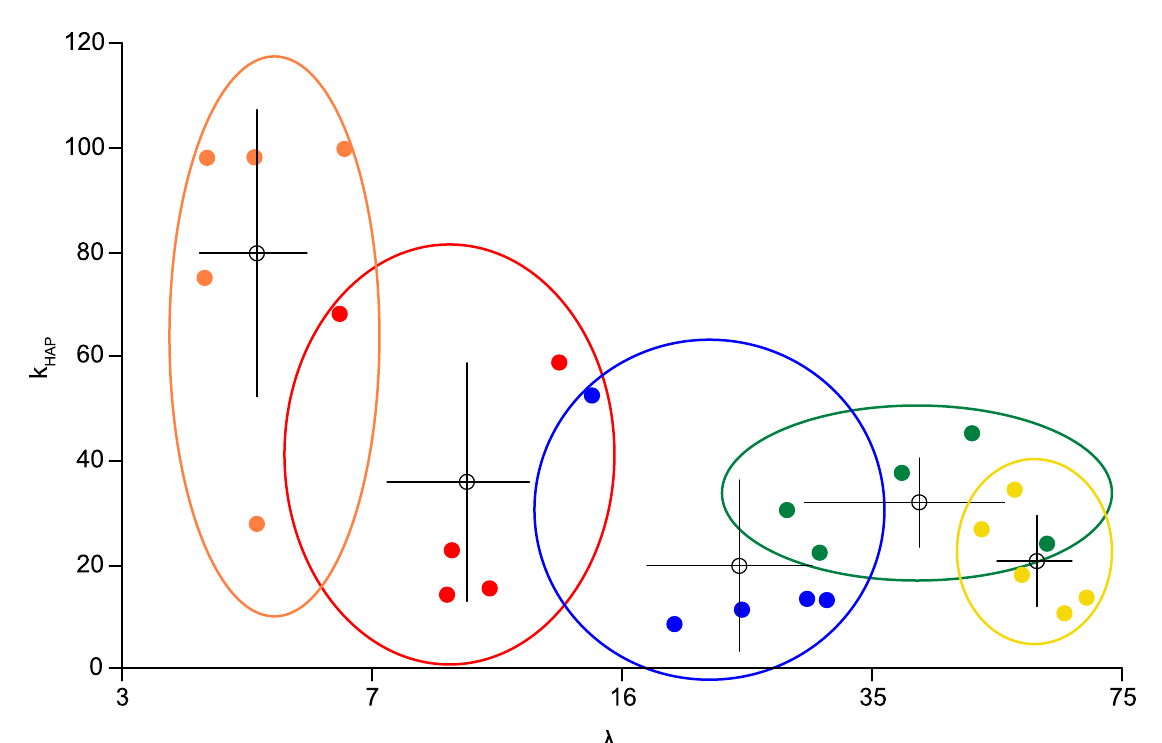
Fig 3. HAP parameter range across cell types and single neuron fits. Each cloud shows five sample fits (each dot a fit) colour coded according to the previously classified VMN cell types (Fig 2). Plotting fits using the HAP fit parameters ( k HAP and λ HAP ), defining the HAP magnitude and half-life, shows a good correlation with cell type. The x-axis is plotted on a natural log scale. The coloured dots show individual cell fits. The white dots and crosses show the mean and standard deviations. The cloud ovals show the range. Longer half-life values tend to correlate with a smaller magnitude. The clouds show overlap, but overall the results are consistent with previous classification, and consistent with the inference that the dominant intrinsic property which differentiates spike patterning across these types is the